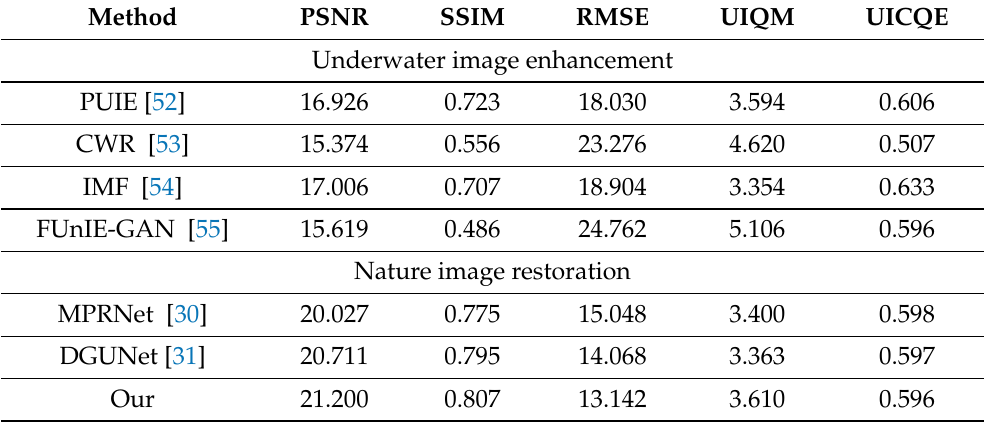
Figure 9. Comparison results of UIR-Net with four other methods on UIBED-Snow. The underwater color images range from 1 to 4, which represent the difficulty of enhanced color correction: 1 represents the smallest color difference between the image to be corrected and the original image, and 5 represents the largest color difference between the image to be corrected and the original image. Table 3. Comparison results of UIR-Net with other SOTA methods on the UIEBD-Snow